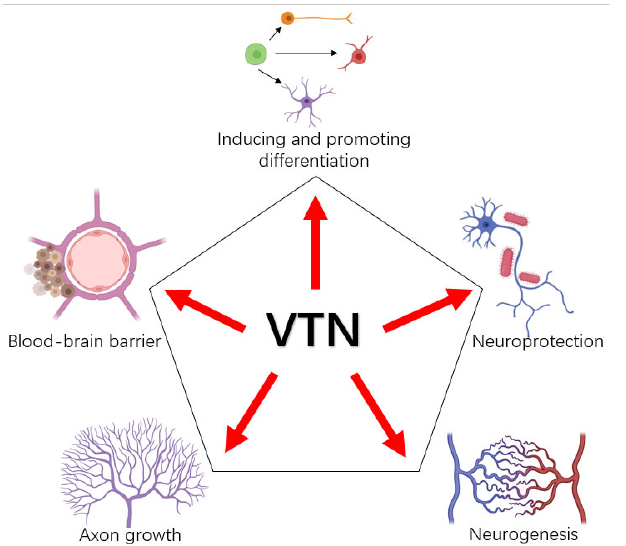
Figure 1. Overview of functions of VTN in neurons. Created with BioRender.com (accessed on 27 August 2022).